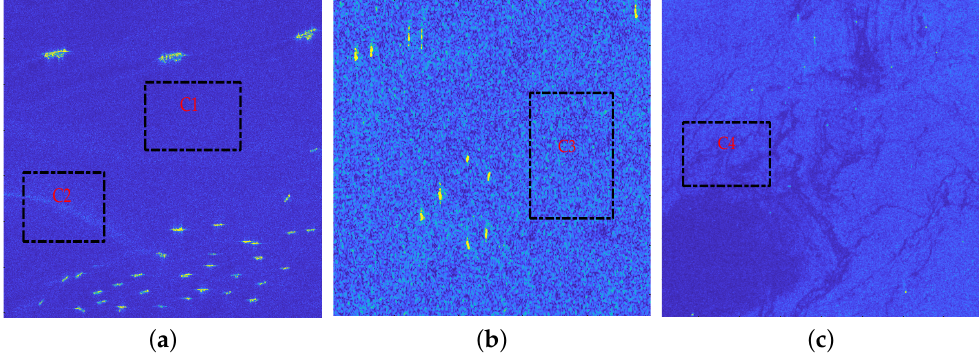
Figure 3. Real SAR scenes. ( a ) Scene 1; ( b ) Scene 2; ( c ) Scene 3. The pure clutter regions C1, C2, C3, and C4 are marked with black dotted rectangles.